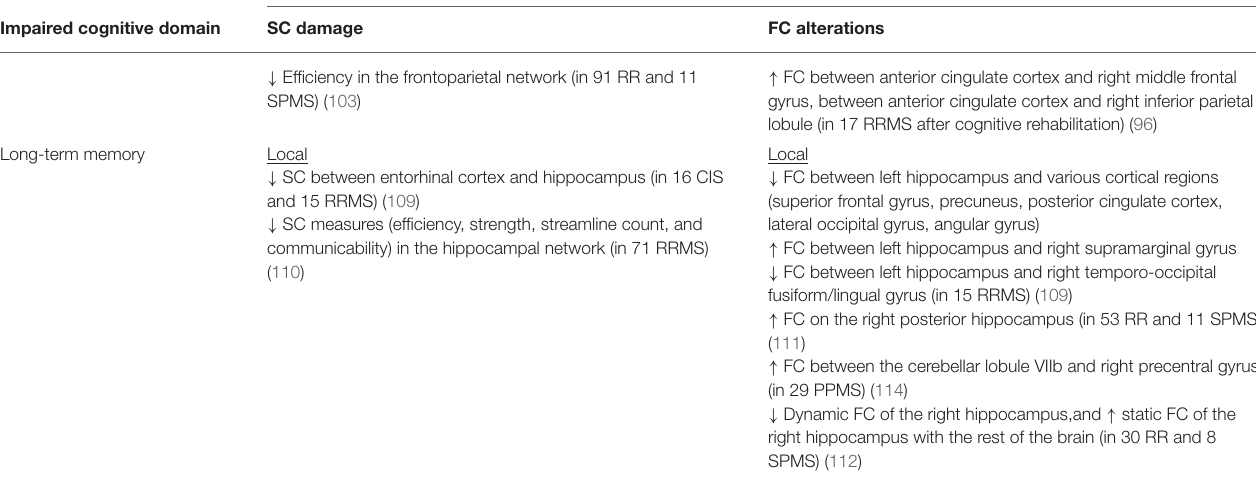
Main findings in patients with CI (compared with HC and/or patients without CI) Impaired cognitive domain